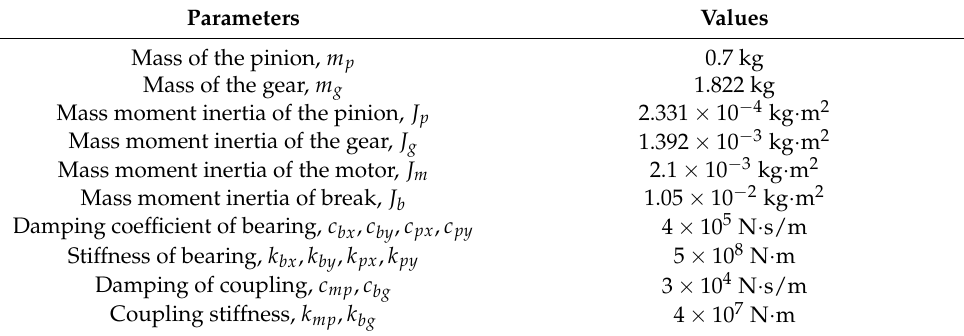
Table 2. Parameters of the spur gear transmission involved in the dynamic simulation. Parameters Values Mass of the pinion, m p 0.7 kg Mass of the gear, m g Mass moment inertia of the pinion, J